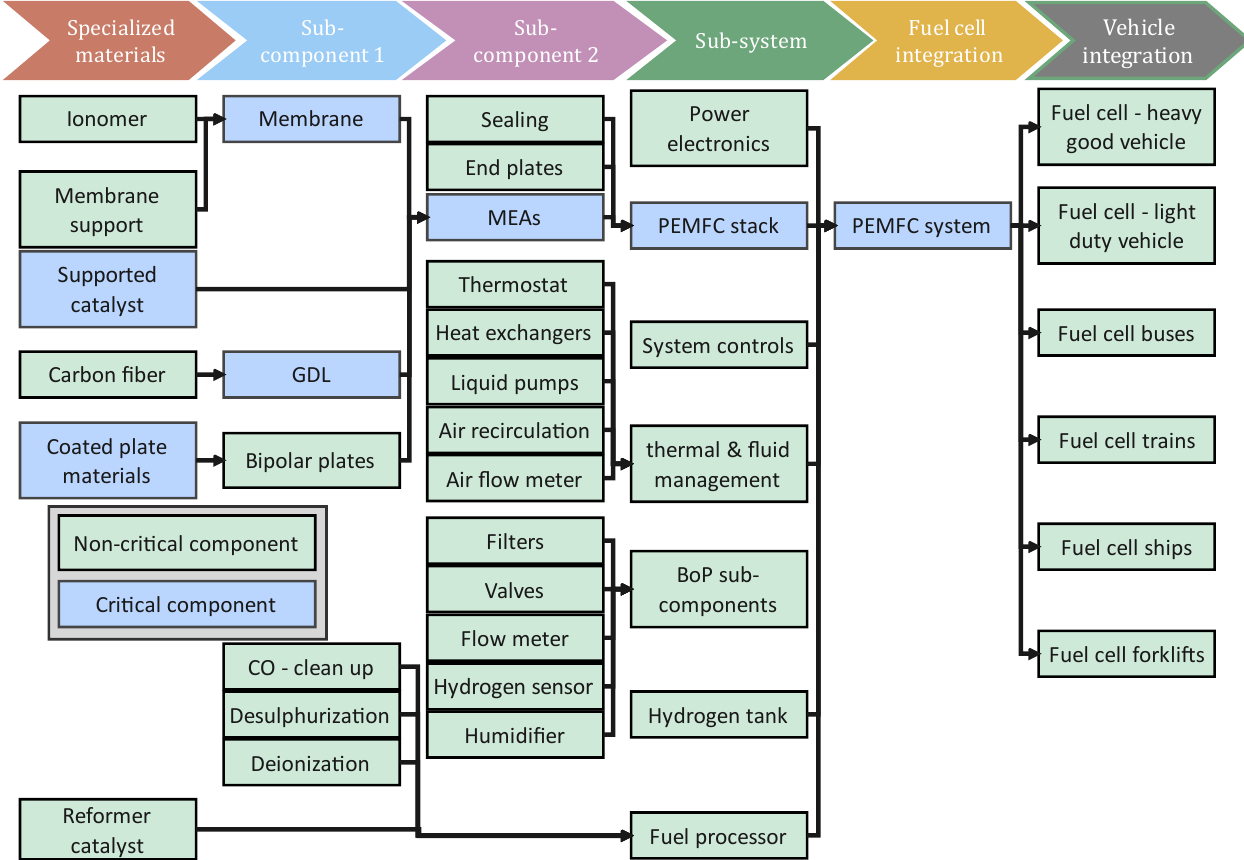
Figure 3. Different components used in PEMFCs and the vehicular applications in different sectors